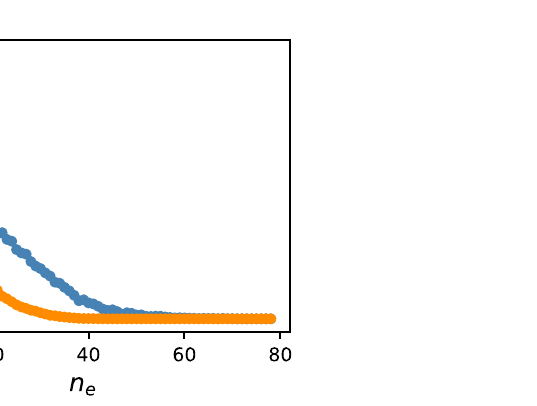
Fig 4. Probability distribution of the number of essential edges n regarded as essential if the fitness f 0 becomes less than 0.8 after the edge is deleted. The orange solid line represents Evo50, and the blue dashed line represents random sampling. The distribution of the ES was corrected using the reweighting method described in the text.